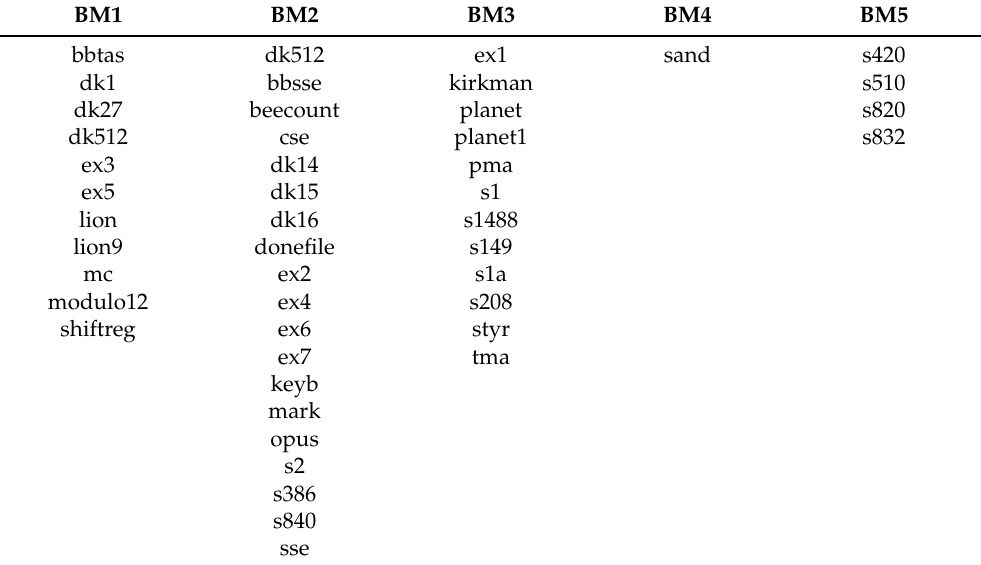
Table 8. Distribution of benchmarks between sets